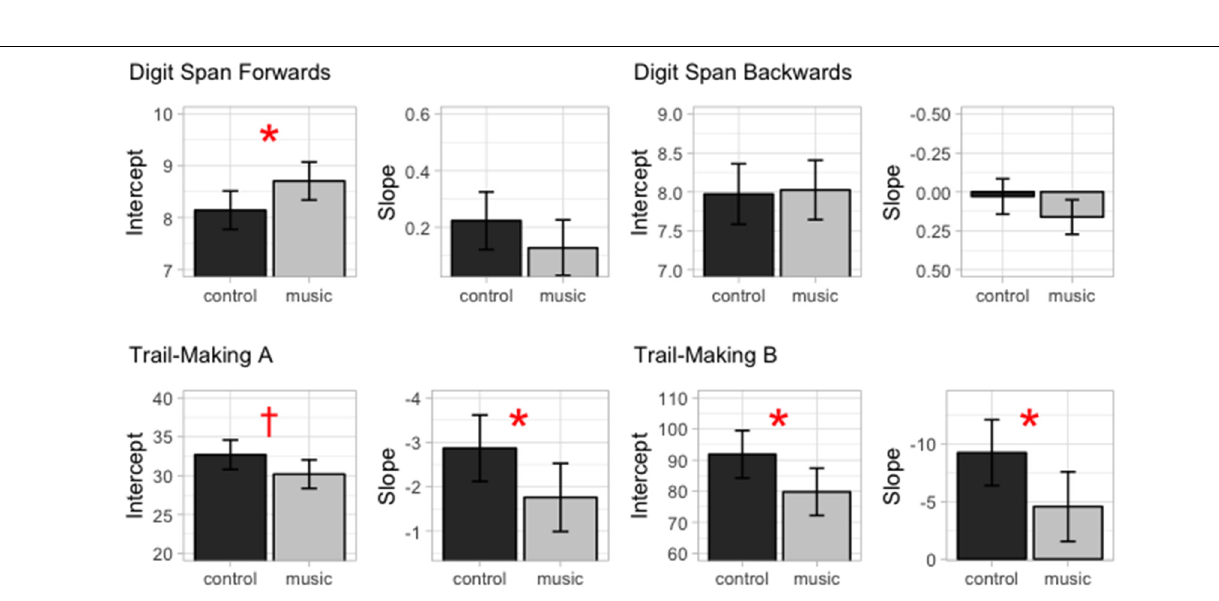
Frontiers in Integrative Neuroscience | www.frontiersin.org